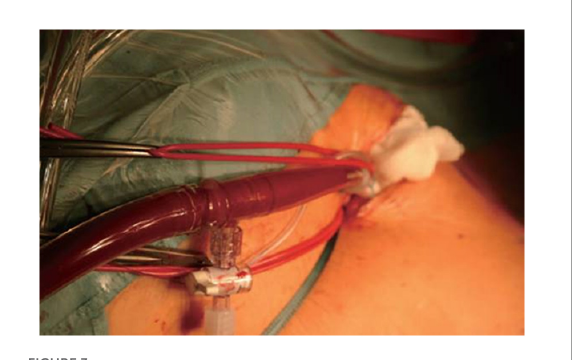
FIGURE3 Intraoperative situs of antegrade arterial perfusion via axillaris artery in minimally-invasive mitral valve